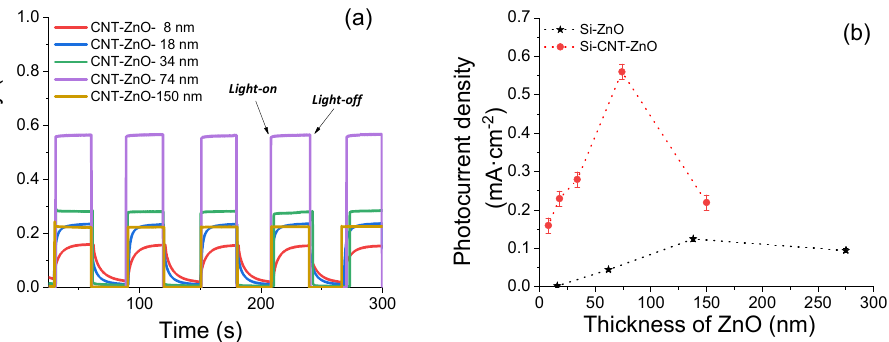
Figure 5. Chronoamperometric measurements at 1.23 V RHE of various ZnO thicknesses on CNT ( a ) and the compared thickness-dependent photocurrent with films on planar Si substrates ( b ).